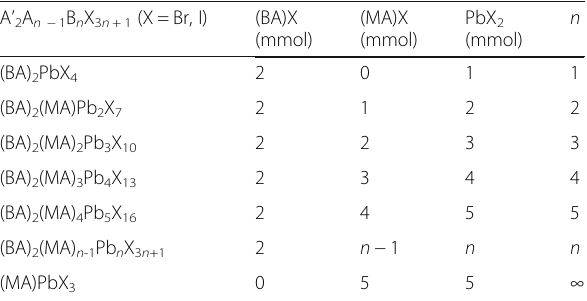
Table 1 The lists of synthesis required compositions for 2D RP perovskite QDs